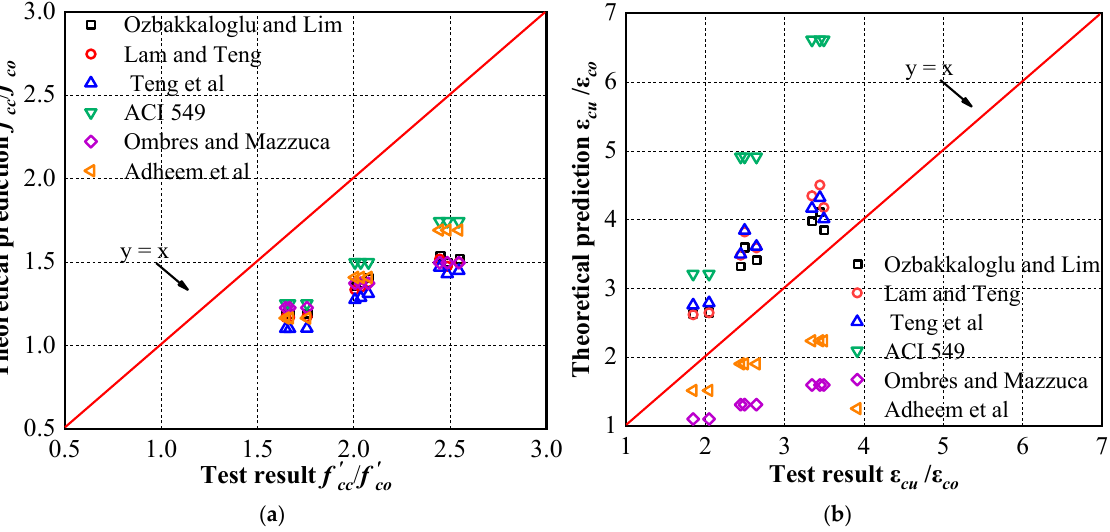
Figure 14. Comparing the performance of the models with the present test results: ( a ) Ultimate axial stress; ( b ) ultimate axial strain.